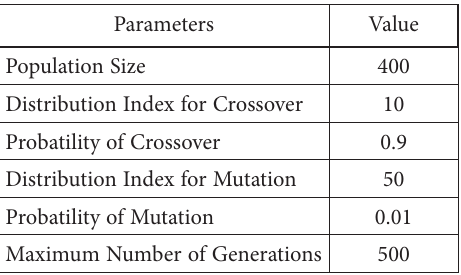
Table 1. Experimental parameters